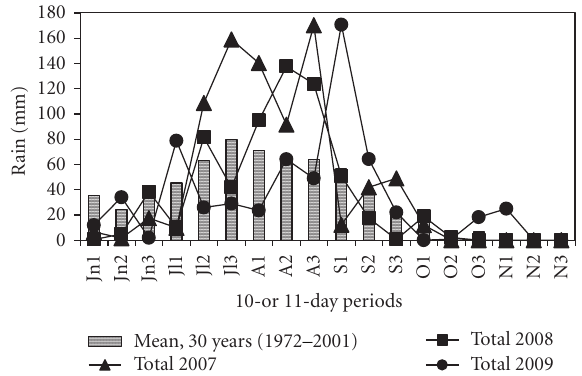
Figure 1: Rainfall in 10- or 11-day periods at Cinzana Agronomic Research Station (1972–2001), 2007, 2008, and 2009.